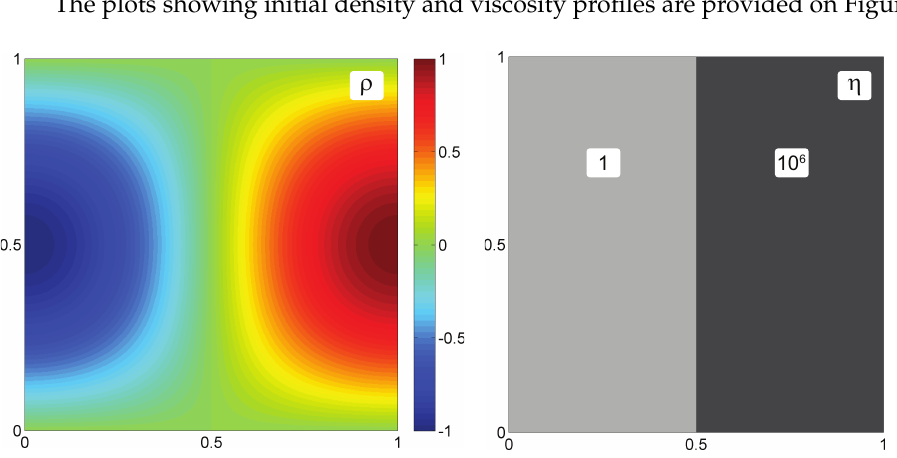
Figure 10. Initial density ( left ) and viscosity ( right )